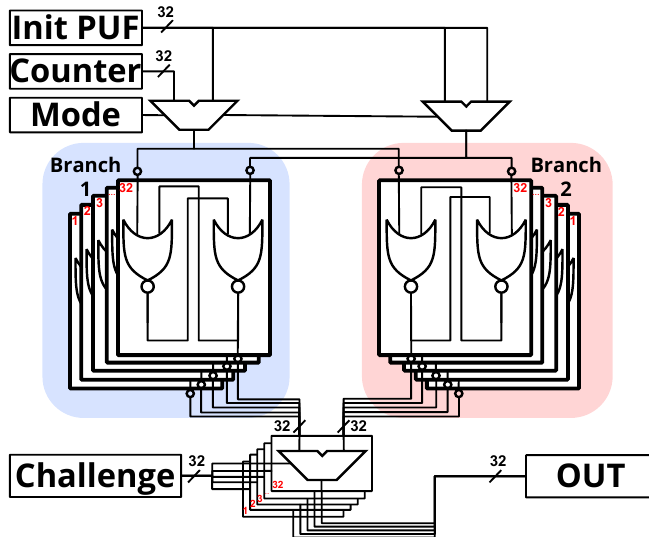
Figure 7. PUF block diagram